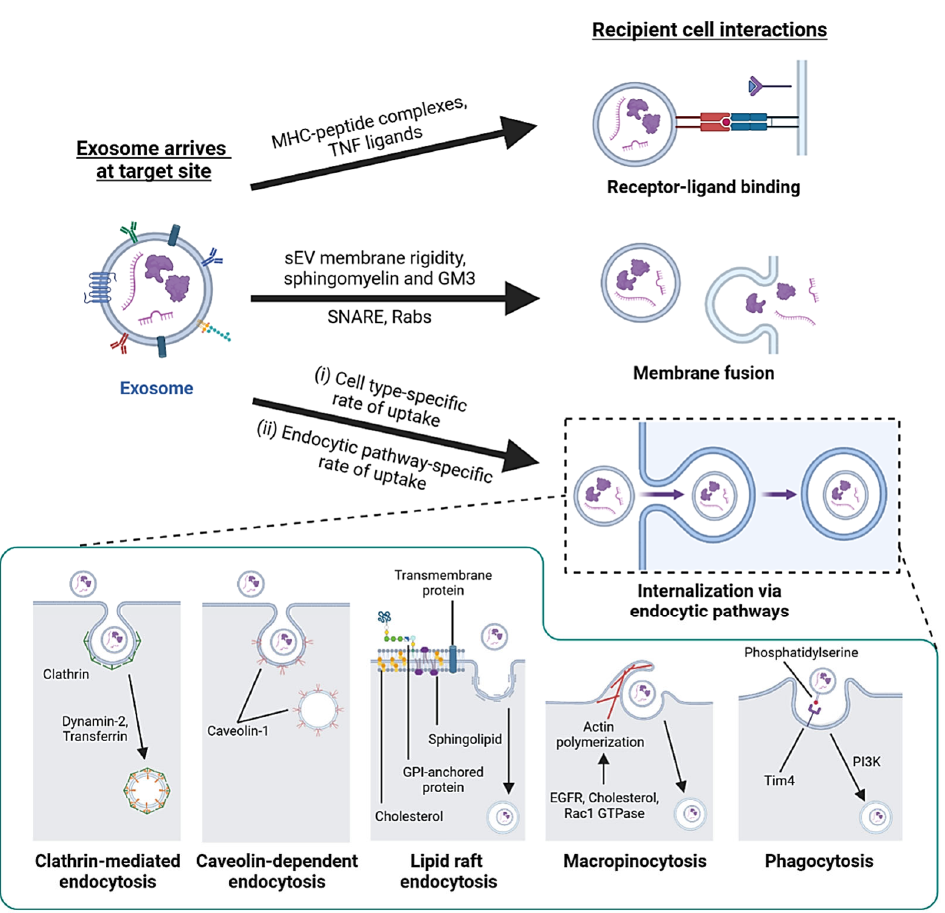
Figure 4. Interactions of exosomes with recipient cells. Exosomes carrying MHC–peptide complexes or TNF ligands undergo receptor–ligand interaction with recipient cells to activate immune cells or trigger apoptosis in cancer cells. Exosomes that have high membrane rigidity and enrichment in sphingomyelin and GM3 have increased fusion efficiency. SNARE and Rab proteins are required for membrane fusion. Most exosomes are taken up by internalization. Different cell types differ in overall exosome uptake efficiency, and each cell may use more than one endocytic pathway for exosome uptake in parallel. Endocytic pathways, such as clathrin-mediated endocytosis (CME), caveolin-dependent endocytosis (CDE), lipid raft endocytosis, macropinocytosis and phagocytosis, contribute to exosome uptake.